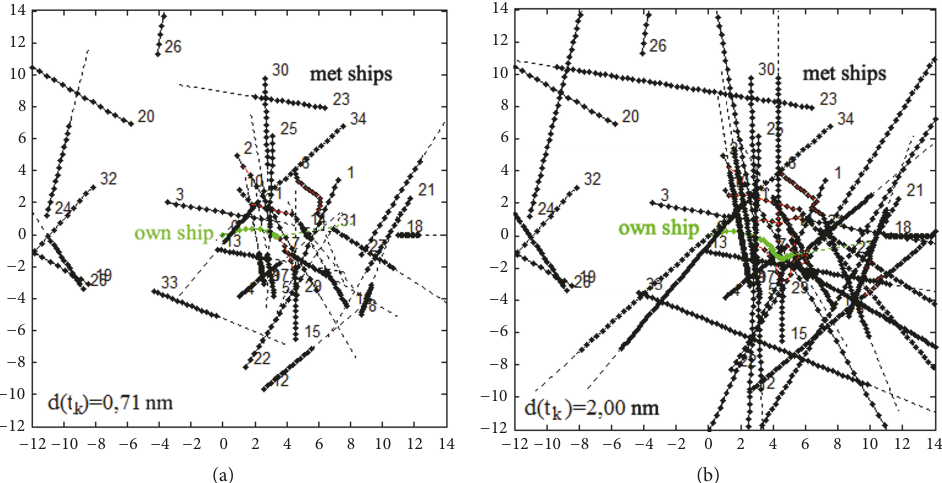
Figure 4: Safe trajectory of own ship in the situation of passing with 𝐽 = 34 met ships, determined by the positional noncooperative game algorithm.